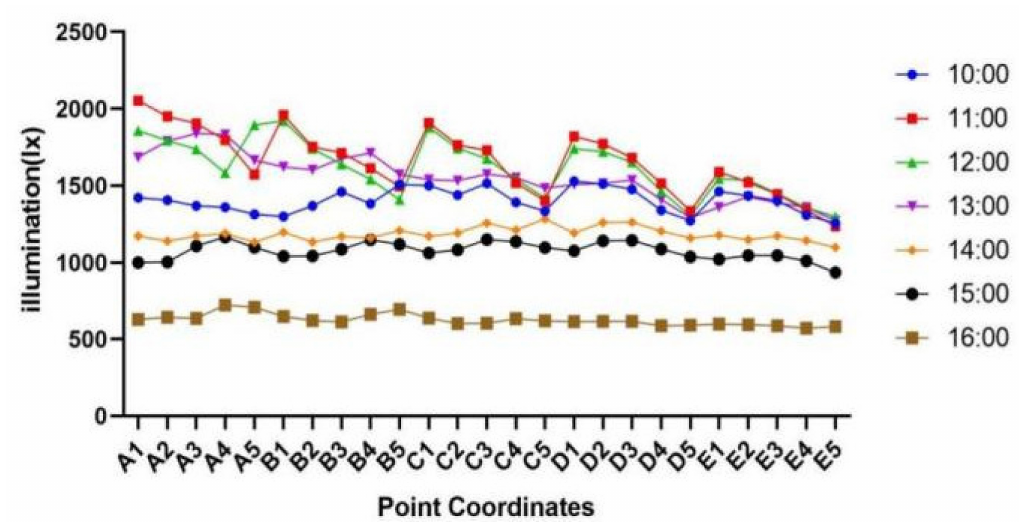
Figure 5. Coordinate diagram of atrium illuminance measurement